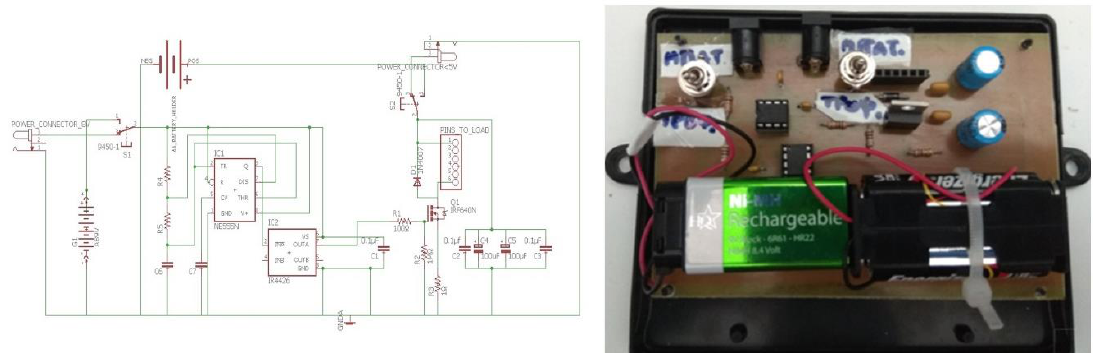
Figure 5. The electronic circuit for the excitation and the detection of the propagating pulsed microstrain of the MDL force sensor.